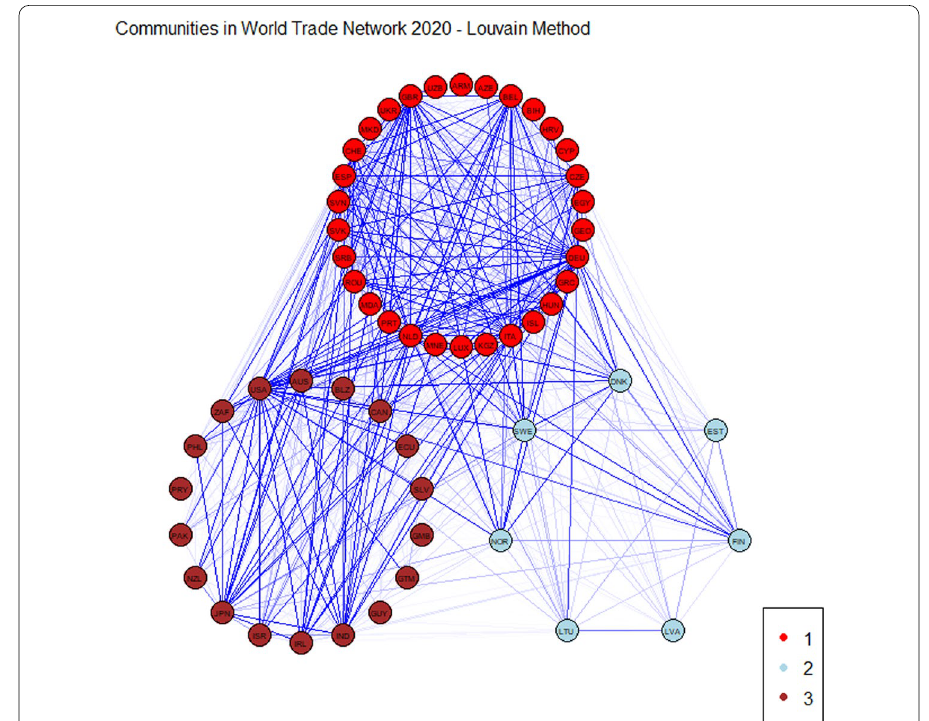
Fig. 6 Communities obtained with the Louvain method referred to